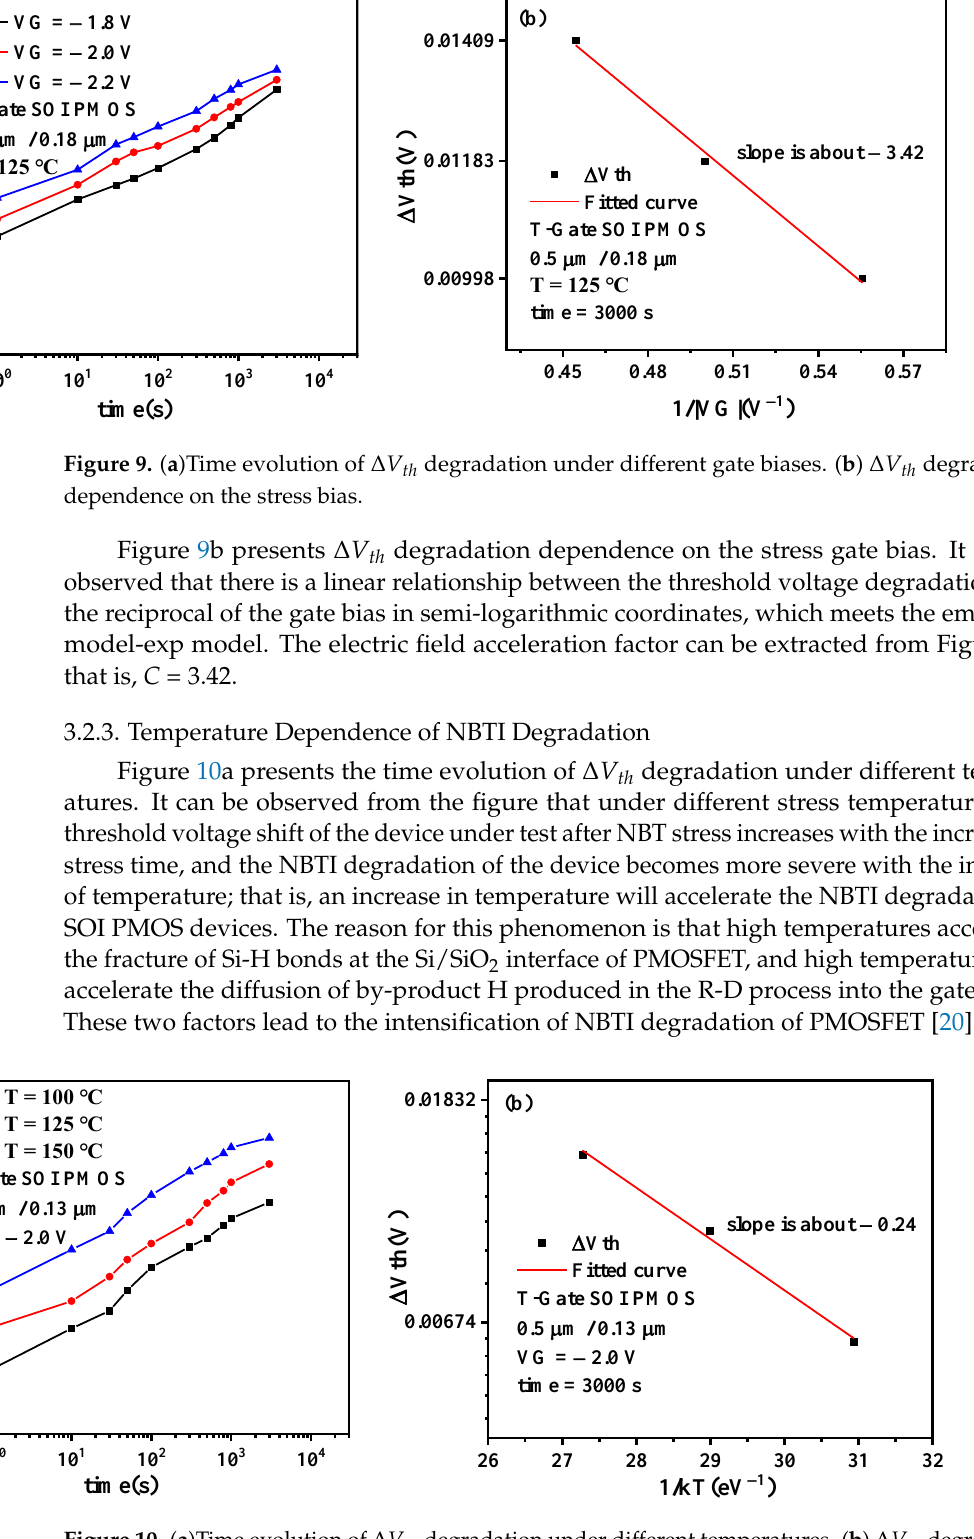
Figure 10. ( a )Time evolution of Δ V th degradation under different temperatures. ( b ) Δ V th degradation dependence on the stress temperature.